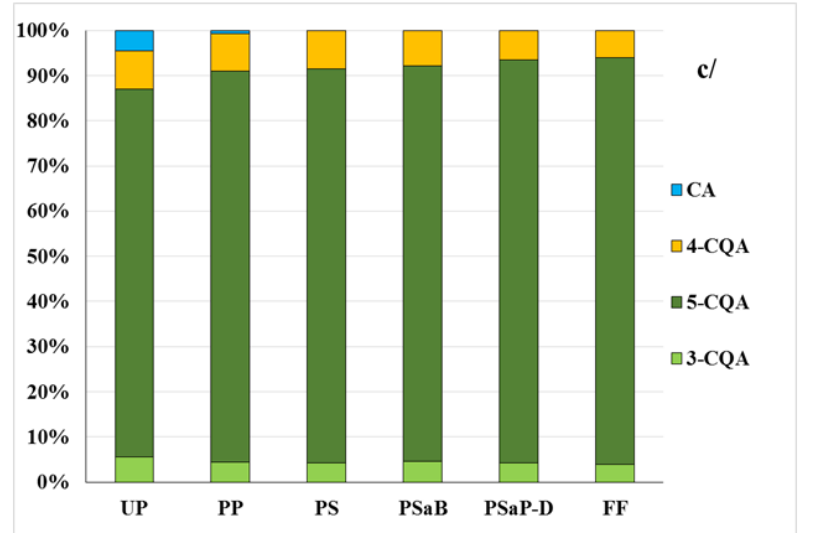
Figure 1. The share of selected hydroxycinnamic acids in their total sum, in the samples obtained during the production of French fries obtained from potatoes: ( a ) (LA) — Lady Anna with light-yellow flesh, ( b ) (MB) — Mulberry Beauty with red-flesh and ( c ) (VQ) — Violet Queen with purple-flesh; 3-CQA (neochlorogenic acid); 5-CQA (chlorogenic acid); 4-CQA (cryptochlorogenic acid); CA — caffeic acid; (UP) — unpeeled potatoes (raw material); (PP) — peeled potatoes; (PS) — potato strips; (PSaB) — potato strips after blanching; (PSaP-D) — potato strips after pre-drying; and (FF) — French fries.